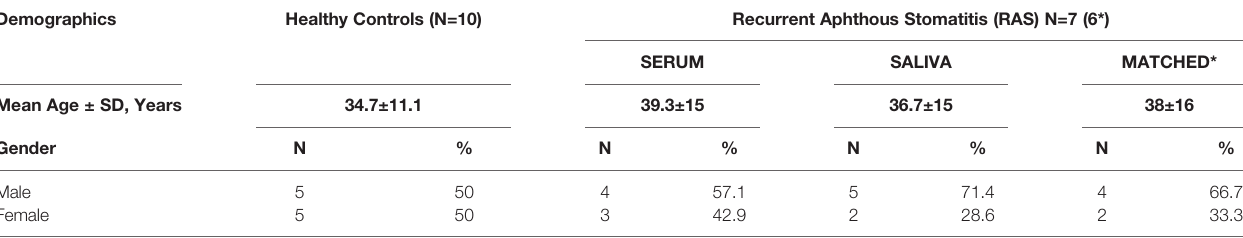
TABLE 1B | Demographics for Healthy Control (HC) and Recurrent Aphthous Stomatitis (RAS) study groups. Demographics